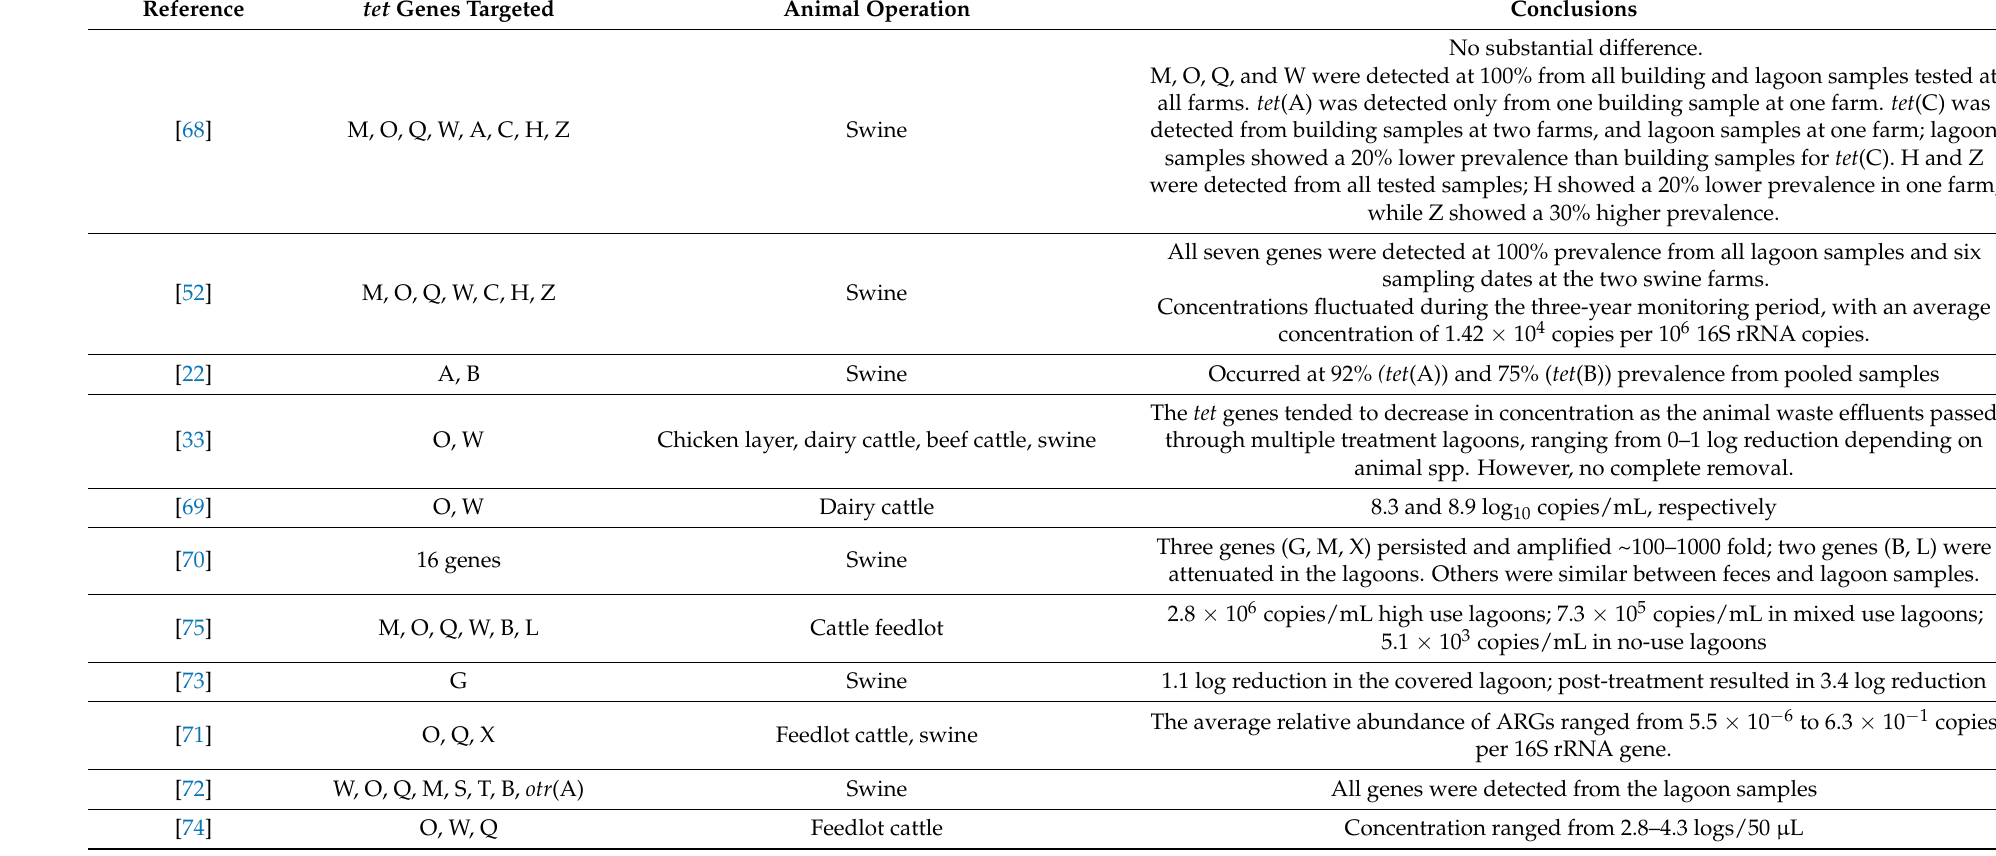
Table 2. Tetracycline resistance genes targeted and detected/quantified from animal waste